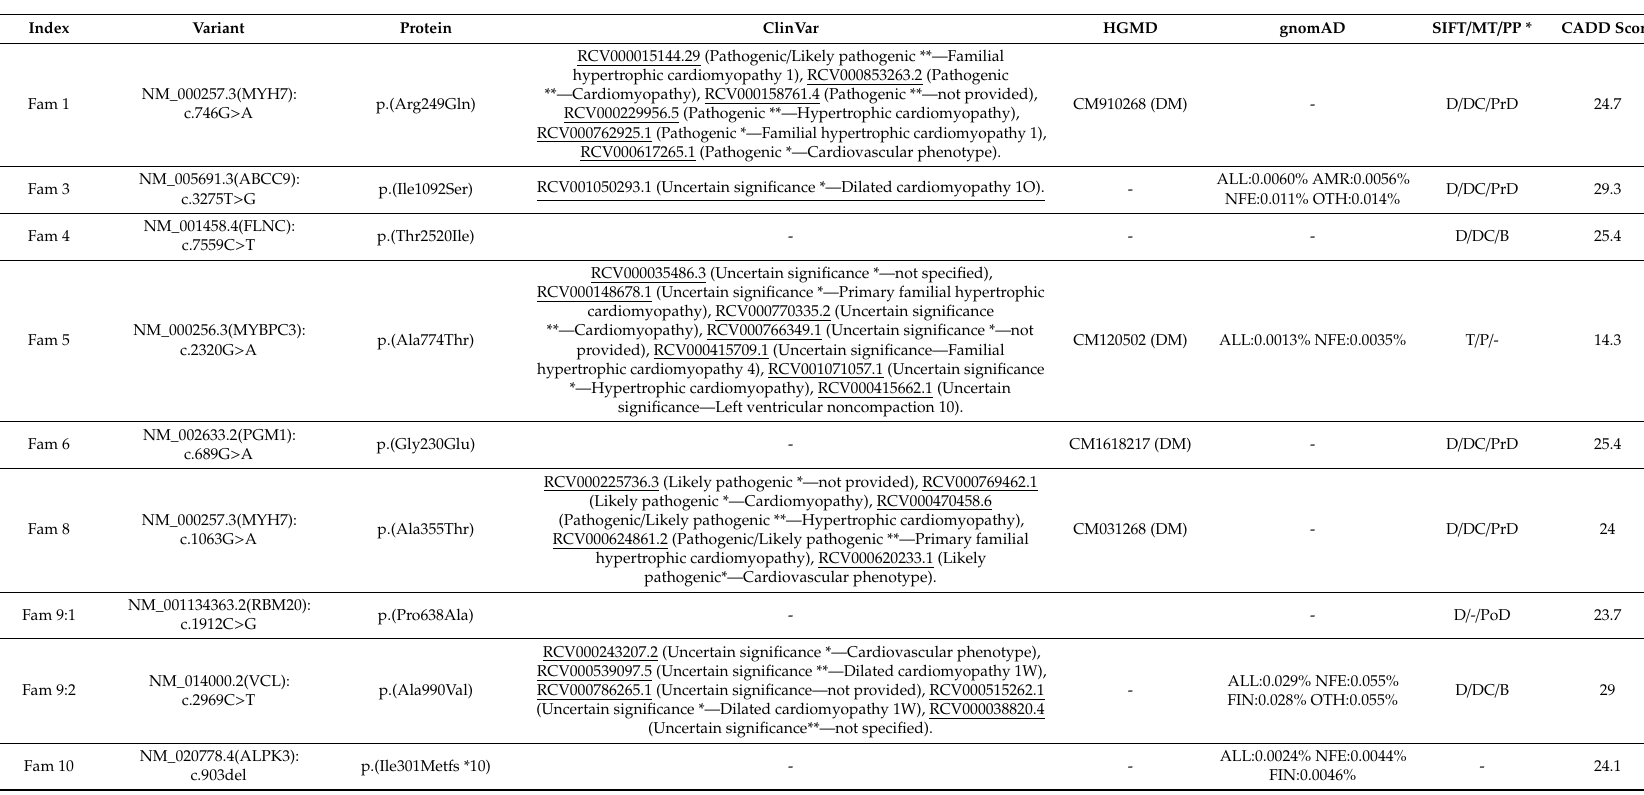
Table 3. Assessment of the pathogenicity of the genetic variants in public online databases and pathogenicity prediction tools. * SIFT: D = Deleterious, T = Tolerated; MT (Mutation Taster): DC = Disease Causing, P = Polymorphism; PP (PolyPhen-2): PoD = Possibly Damaging, PrD = Probably Damaging, B =